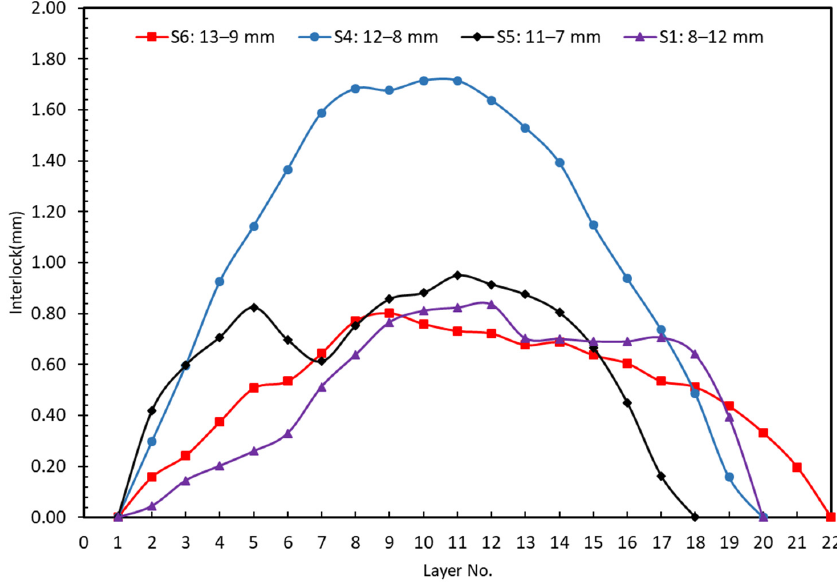
Figure 18. Comparison of layers interlock between S1, S4, S5 and S6.